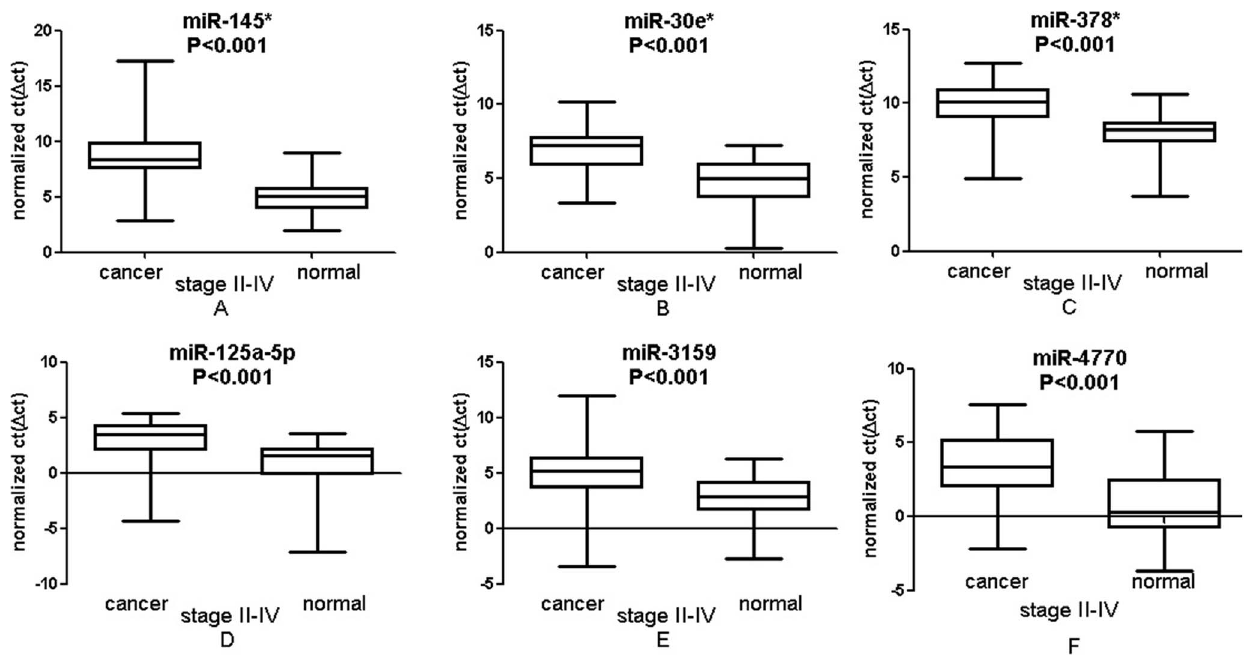
Figure 4. Expression levels of dysregulated miRNAs. Box plots of expression levels of six miRNAs in both tumors and paired normal tissues. The relative level of the six miRNAs was normalized to internal control gene and was showed as normalized CT. The line represents the median value—the higher the value, the lower the expression level. Paired t-tests were performed to examine the differences in miRNAs between tumors and the paired normal tissues.